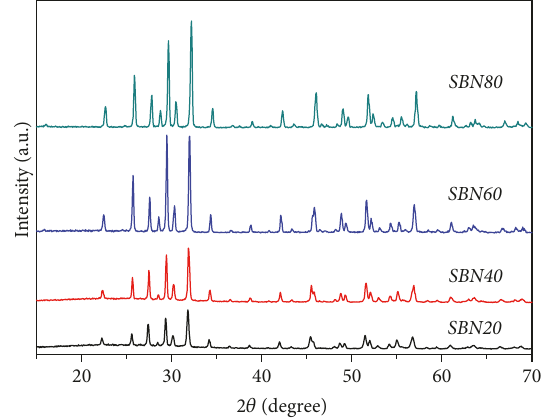
Figure 4: XRD patterns of the flux-synthesized SBN60 nanocrystals with flux-to-reactant weight ratio of 2 :1 at different reaction temperatures for